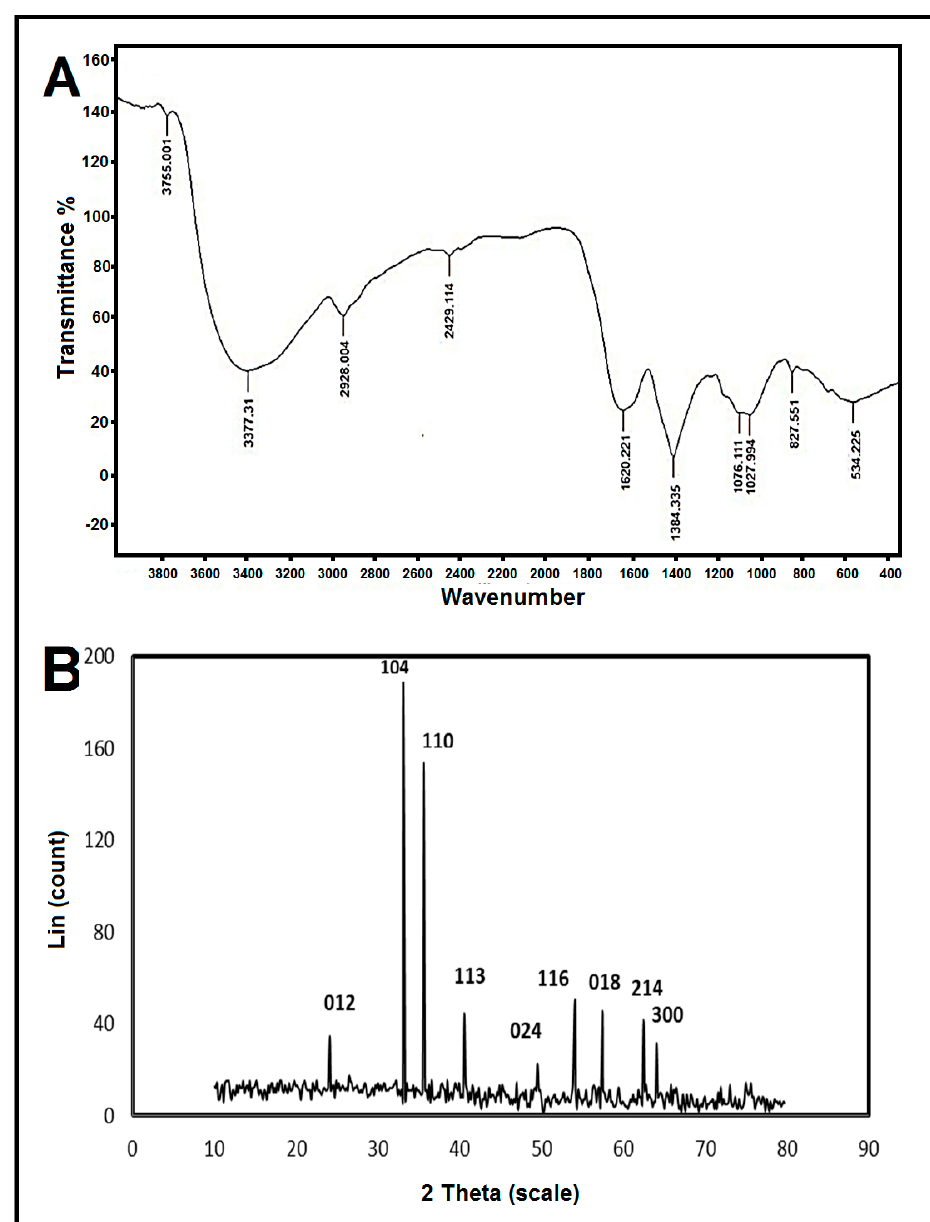
Figure 4. ( A ) FTIR spectrum and ( B ) XRD spectrum of Hem-NPs .